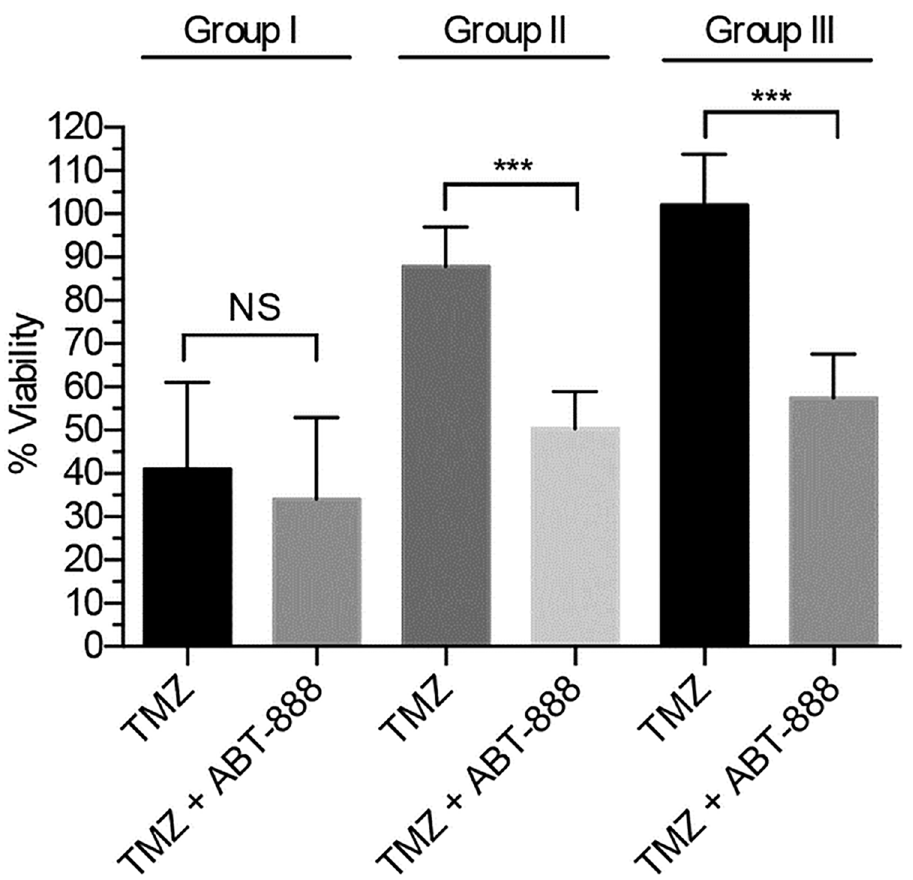
Fig 4. Average viability of BTICs in Group I vs .II vs .III (n = 3, ± SD). The unpaired t-test was applied to assess differences. On average, Group I was TMZ sensitive whereas Groups II and III were not. The addition of ABT-888 potentiated TMZ cytotoxicity in Groups II and III, but had no such potentiating effect in Group I (ns = p > 0.05; (cid:3)(cid:3)(cid:3) = p <